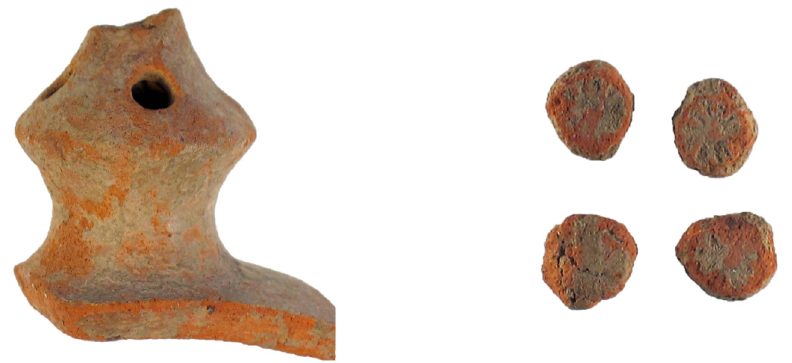
Figure 12. PC19920024, an Orientalizing fenestrated impasto vessel fragment and associated frag- ments found within the finial preserving stamped designs, 675/650-600 BCE (Image: Poggio Civitate Project).